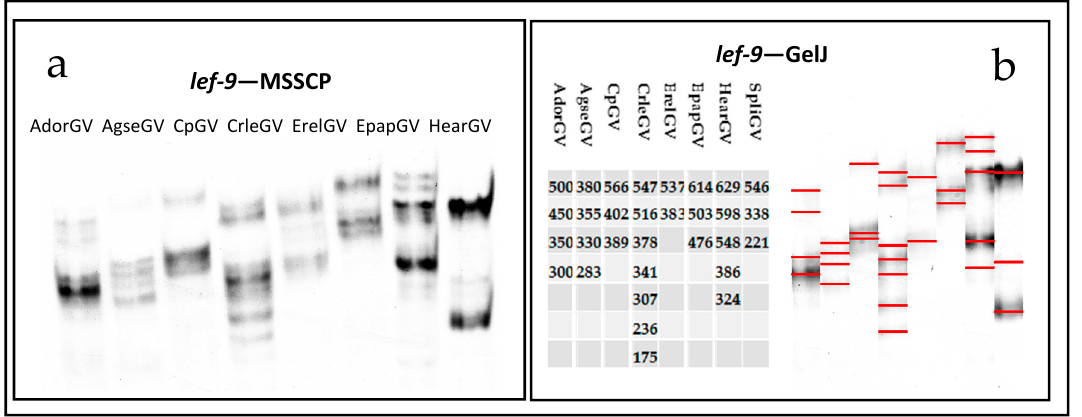
Figure 5. ( a ) Late expression factor-9 gene fragments visualized with silver staining after Multitemperature Single Stranded Conformational Polymorphism analysis. ( b ). Table and picture generated by GelJ software. Different band patterns (marked with red lines) and calculated numerical fingerprints represent specific betabaculovirus species.